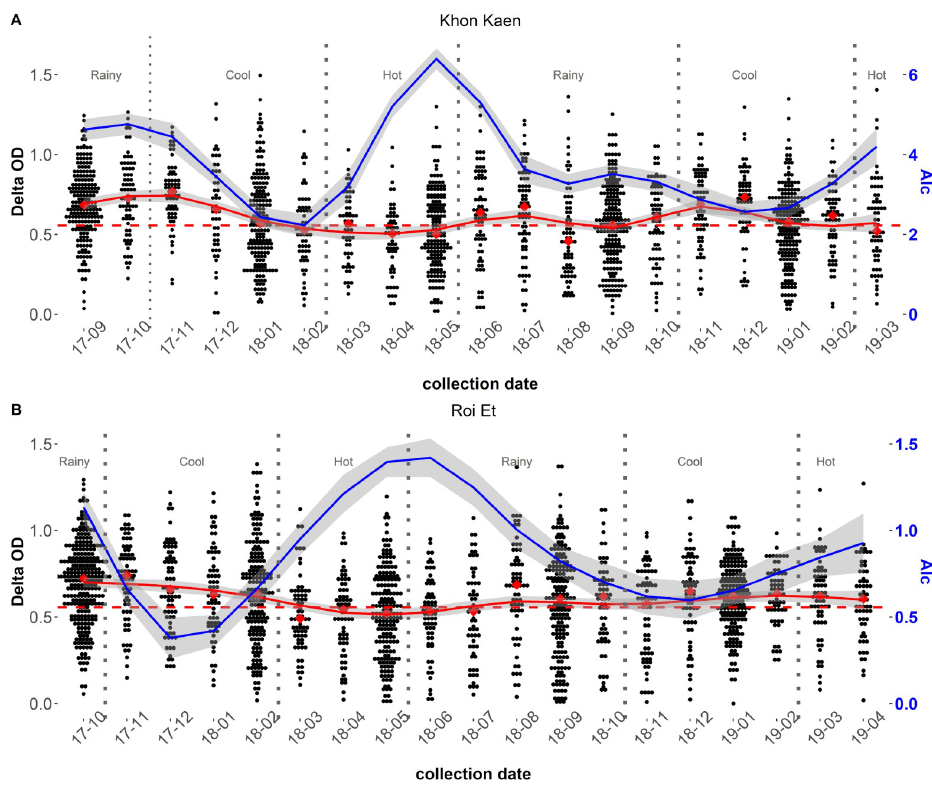
Fig 3. Seasonal variations of the human IgG response to Aedes Nterm-34kDa salivary biomarker and the adult density Aedes Index (AI c ), between September 2017 and April 2019 in Khon Kaen (A) and Roi Et (B) northeastern Thailand. The dot plots represent the individual IgG immune response to the Aedes salivary peptide Nterm-34 kDa ( Δ OD). The red diamonds represent the median response during each survey. The solid red lines represent the means and the grey shaded areas represent the confidence interval of the IgG response to the salivary biomarker. The red dashed horizontal lines represent the specific immune threshold TR. The solid blue lines represent the means and the grey shaded areas represent the 95% confidence interval respectively, for the AIc at the cluster